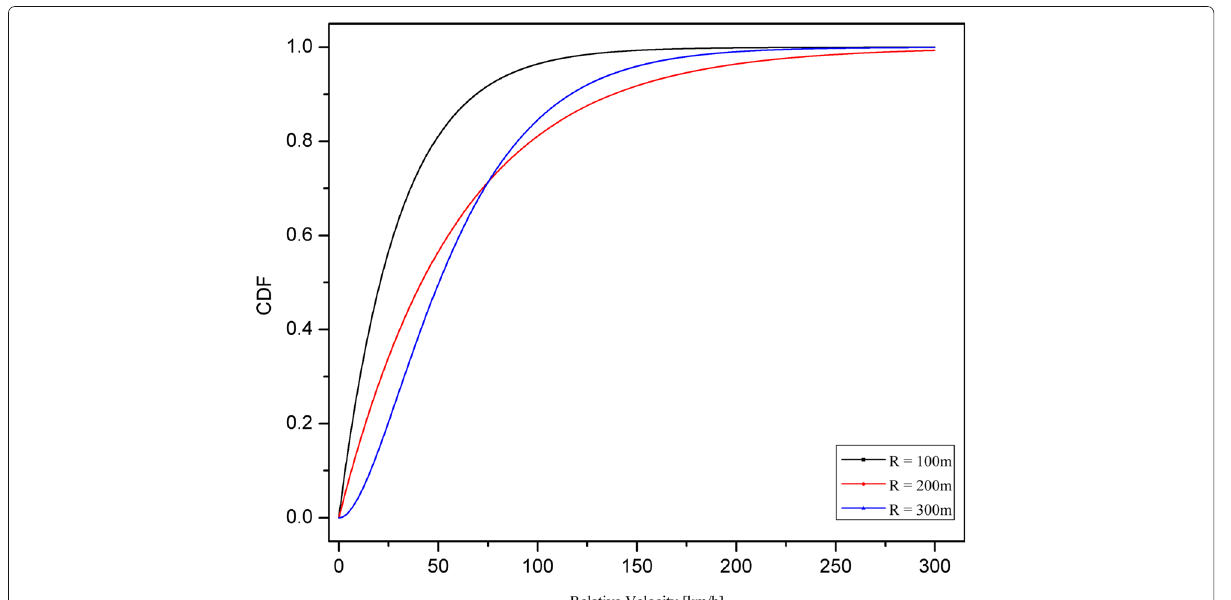
Fig. 5 Cumulative density function (CDF) of vehicles’ relative velocity